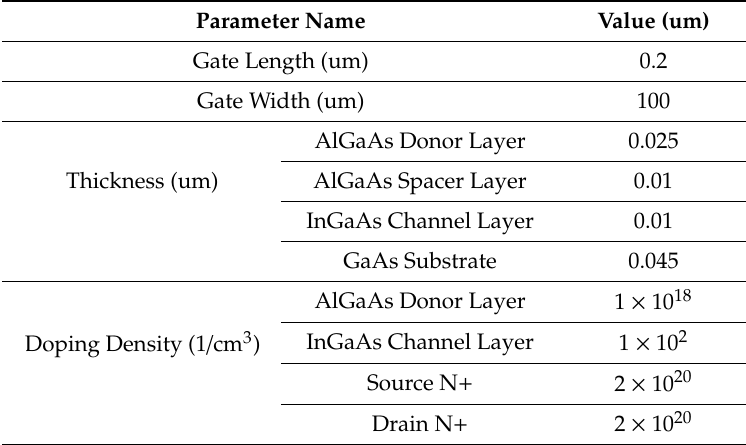
Table 5. Training data and test data for GaAs HEMT.